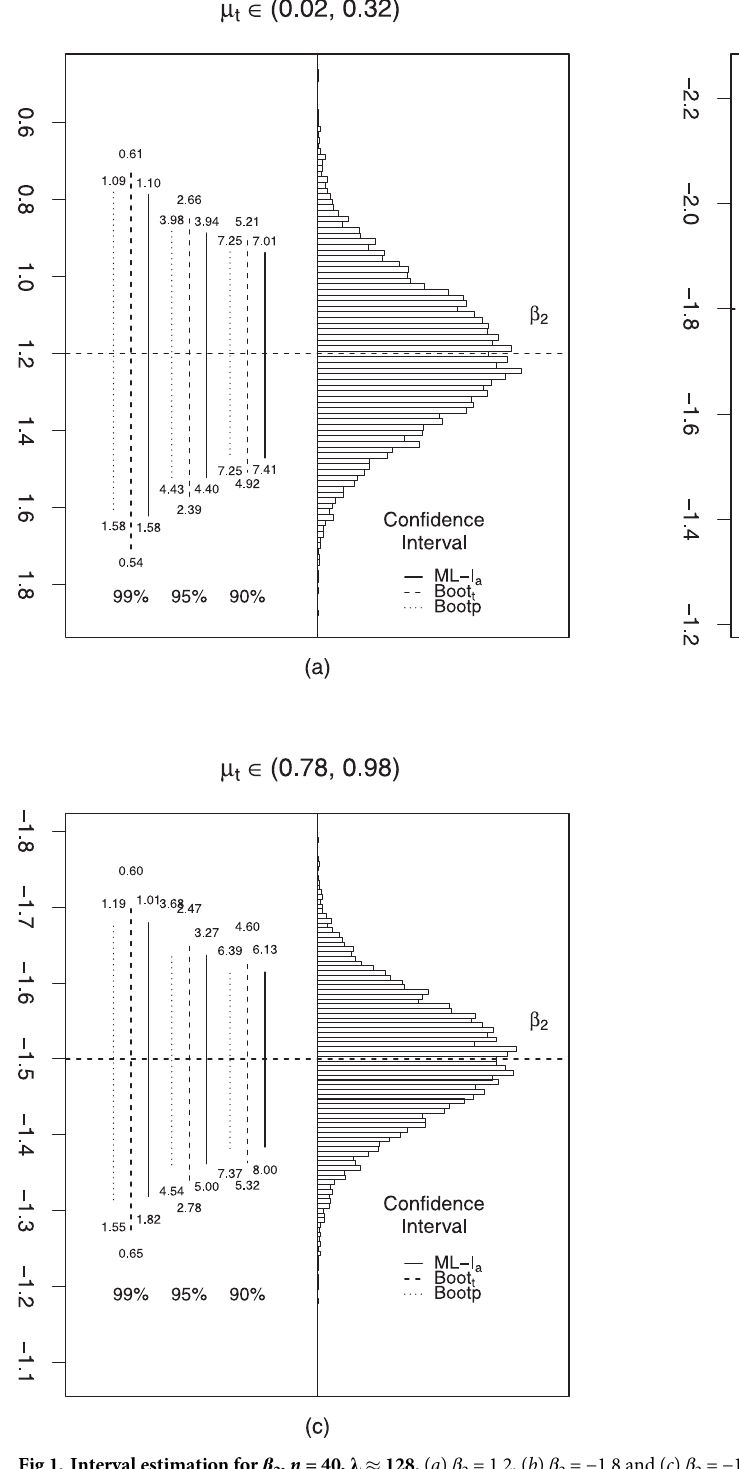
PLOS ONE | https://doi.org/10.1371/journal.pone.0272512 August 9,